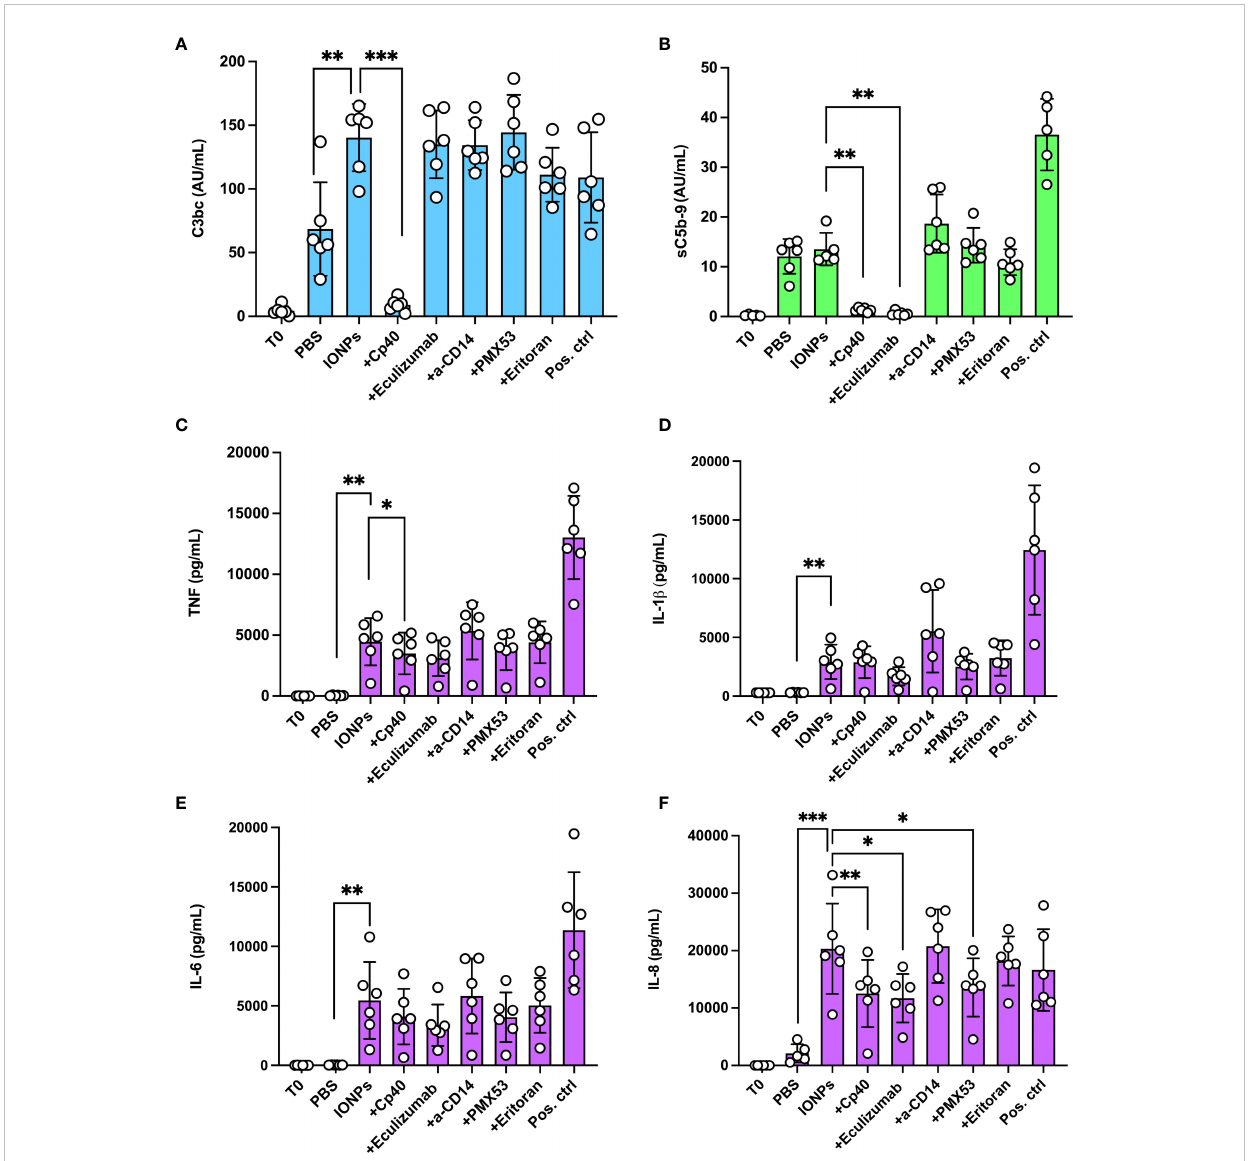
FIGURE 2 Effect of complement inhibition on complement activation and cytokine release by IONPs in whole blood. Human whole blood was incubated with a mixture of IONPs (100 m g/mL) of different sizes; 10, 20, and 30 nm in the presence of inhibitors; Cp40 (20 m M), eculizumab (100 m g/mL),